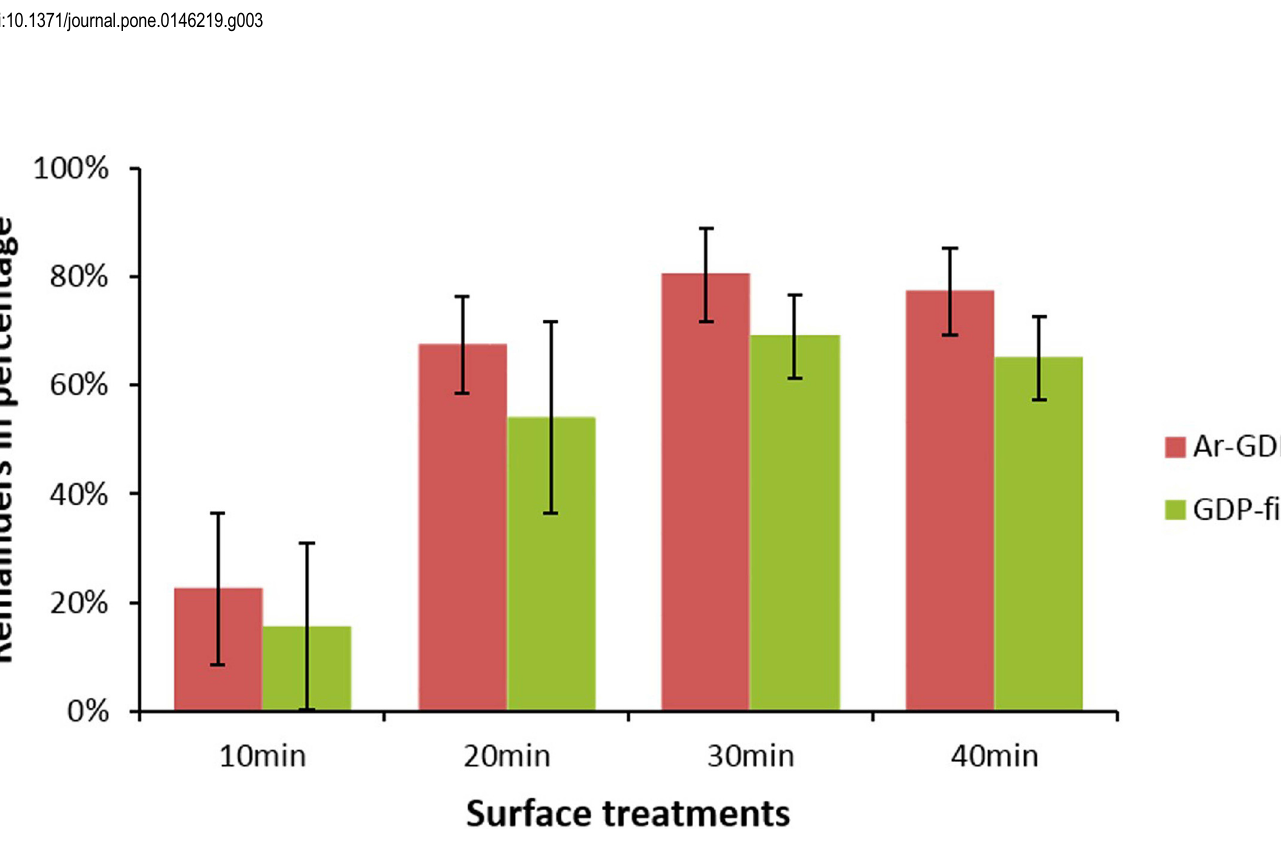
PLOS ONE | DOI:10.1371/journal.pone.0146219 January 5,